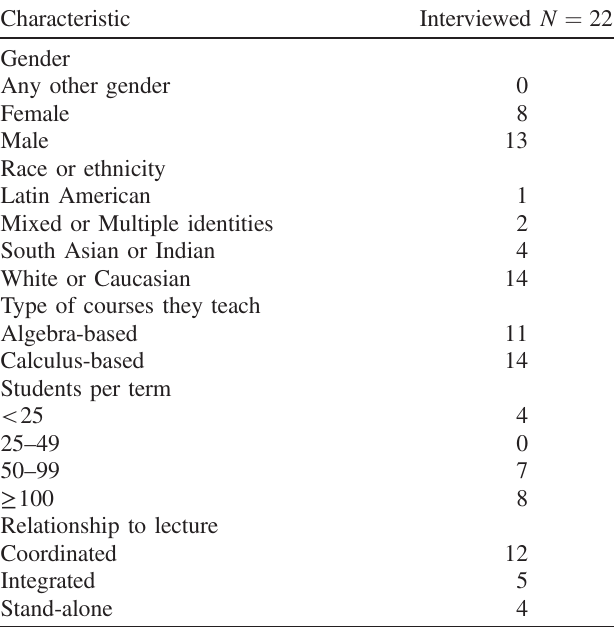
Table I. Information about those instructors, and the lab